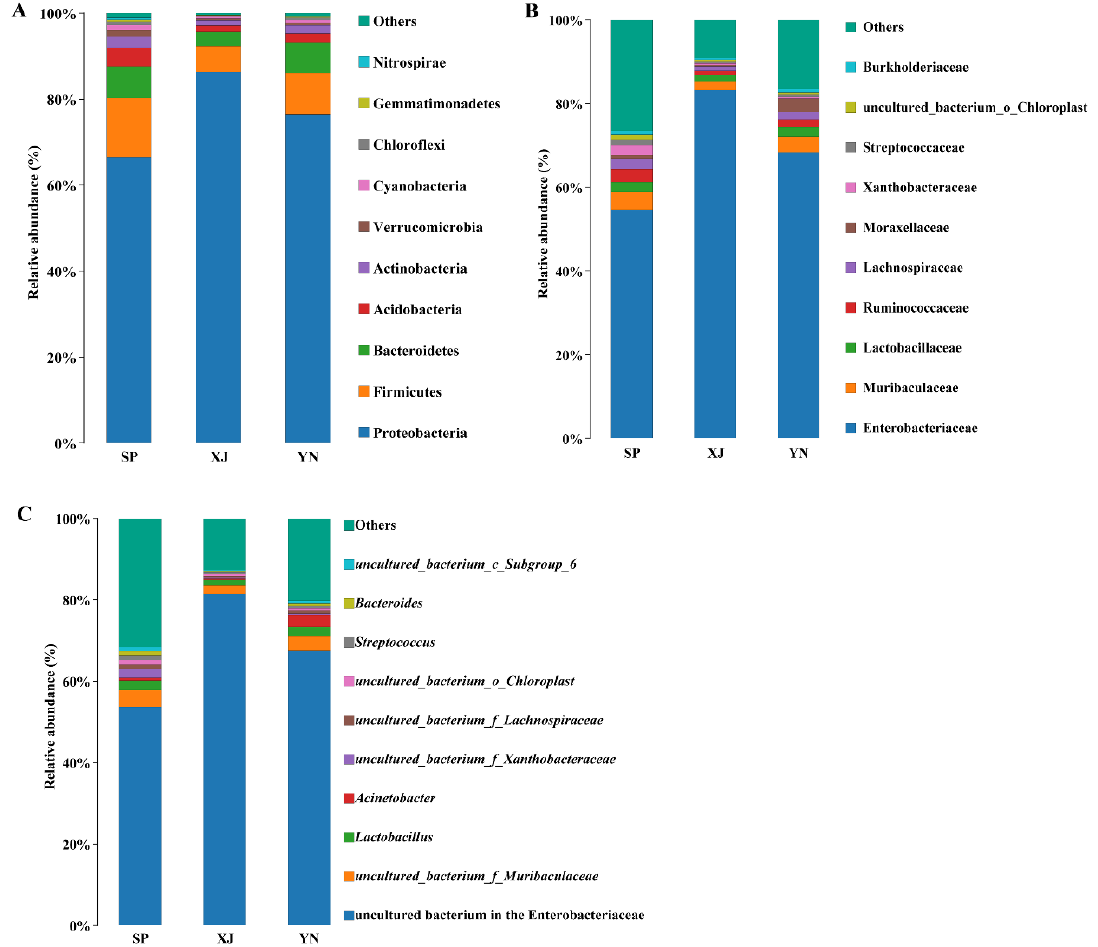
Figure 3. Species distribution in all samples. Abbreviations: SP, Spain; XJ, Xinjiang; YN, Yunnan. ( A ) Relative abundance of the top 10 bacteria at the phylum level in T. absoluta from three geographical populations. ( B ) Relative abundance of the top 10 bacteria at the family level. ( C ) Relative abundance of the top 10 bacteria at the genus level.